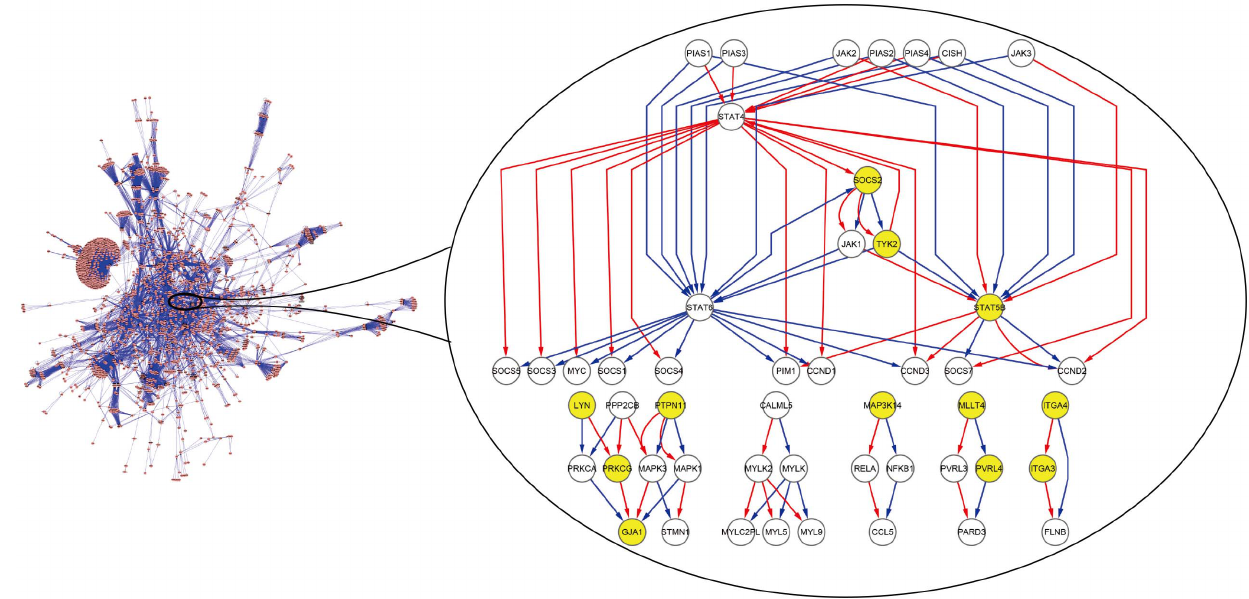
Figure 5. Integrated deregulated module. The figure shows the integrated deregulated module consisting of 49 gene nodes and 86 directed edges, which include both 43 edges belonging respectively to the control (colored by blue) and the case group (colored by red). The seed genes are colored by yellow. Note that not all the 20 seed genes appear in the deregulated module. doi:10.1371/journal.pone.0070412.g005 PLOS ONE |